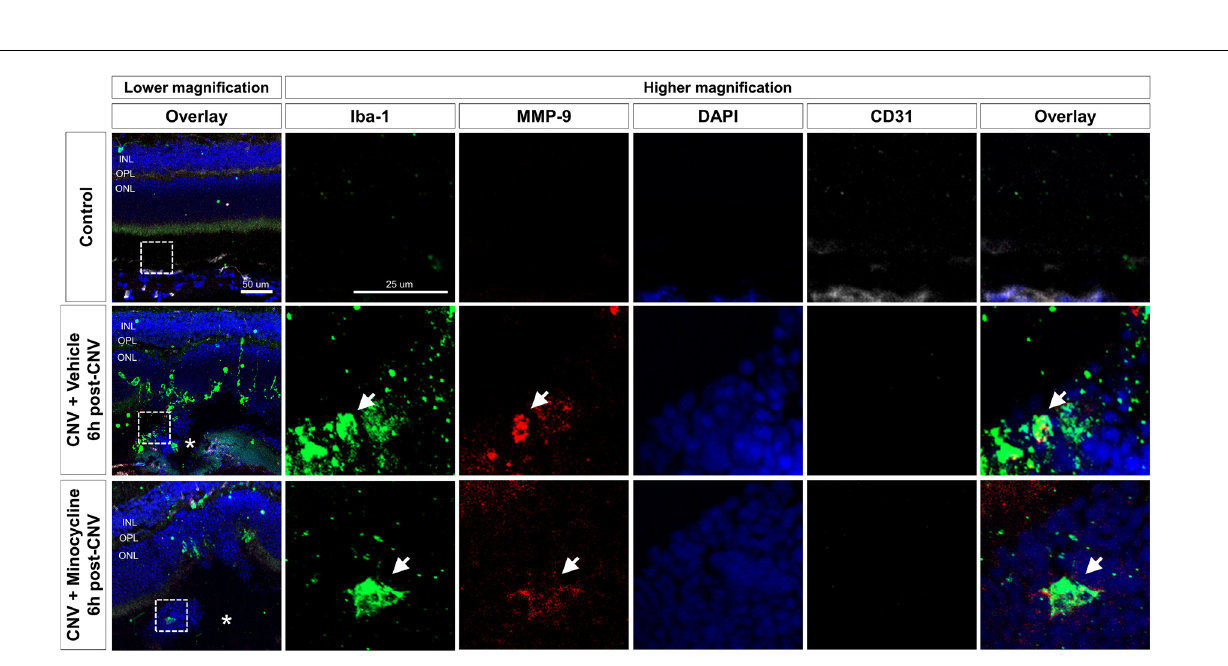
Frontiers in Cellular Neuroscience |